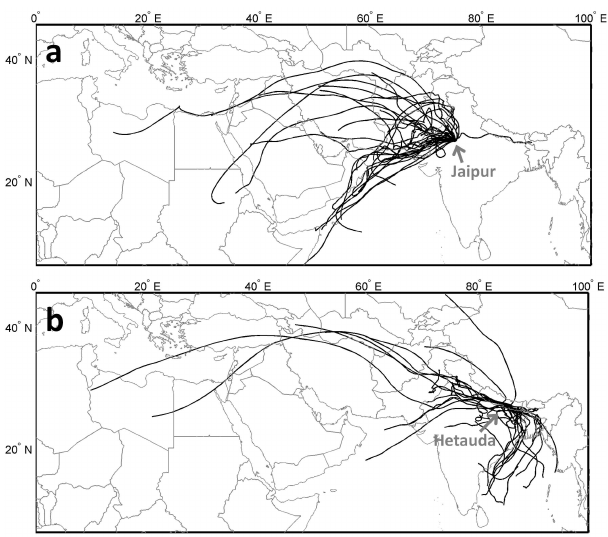
Fig. 5. Five-day backward trajectories of airmass (1500 m above ground level) ending at (a) Jaipur (Northwestern India) and (b) Het- auda (Nepal) from 1–31 May 2009. Note, elevation of Jaipur and Hetauda is 450m and 465m above mean sea level, respectively. Lo- cations of Jaipur and Hetauda are indicated by